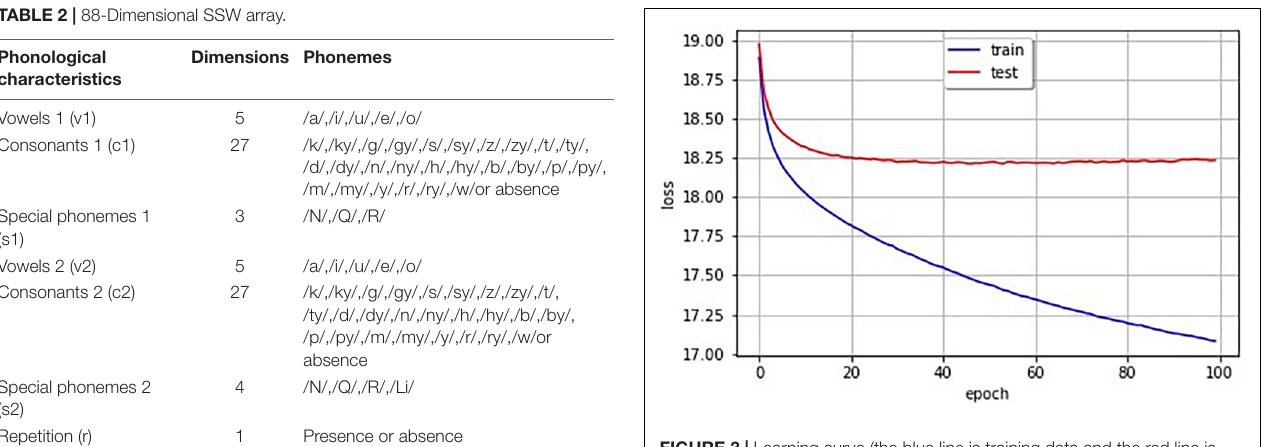
FIGURE 3 | Learning curve (the blue line is training data and the red line is test data).